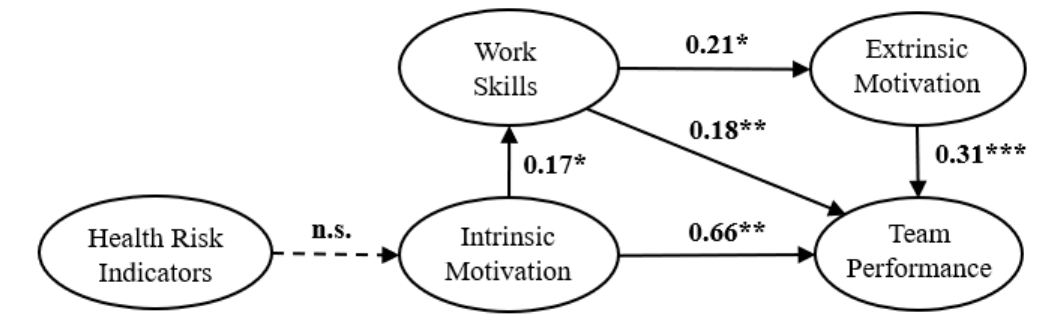
Figure 2. The standardized parameter estimates in the final model for Group A. *: p < 0.05; **: p < 0.01; ***: p < 0.001; n.s.: not significant. The path coefficients are expressed in standardized estimates. Int. J. Environ. Res. Public Health 2021 , 18 , x FOR PEER REVIEW